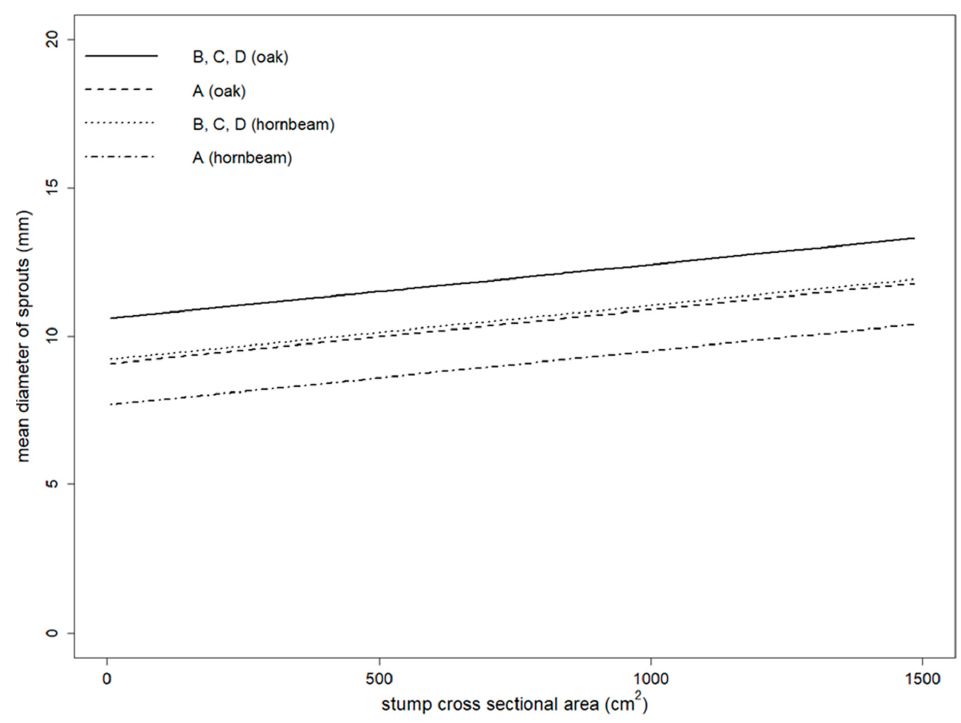
Forests 2019 , 10 , x FOR PEER REVIEW Figure 3. Fitted values of the average sprout diameter in relation to the stump cross sectional area, the species, and the management type (A: coppice-with-standards + raking + grazing; B: coppice-with-standards + grazing; C: coppice-with-standards + raking; and D: coppice-with-standards).